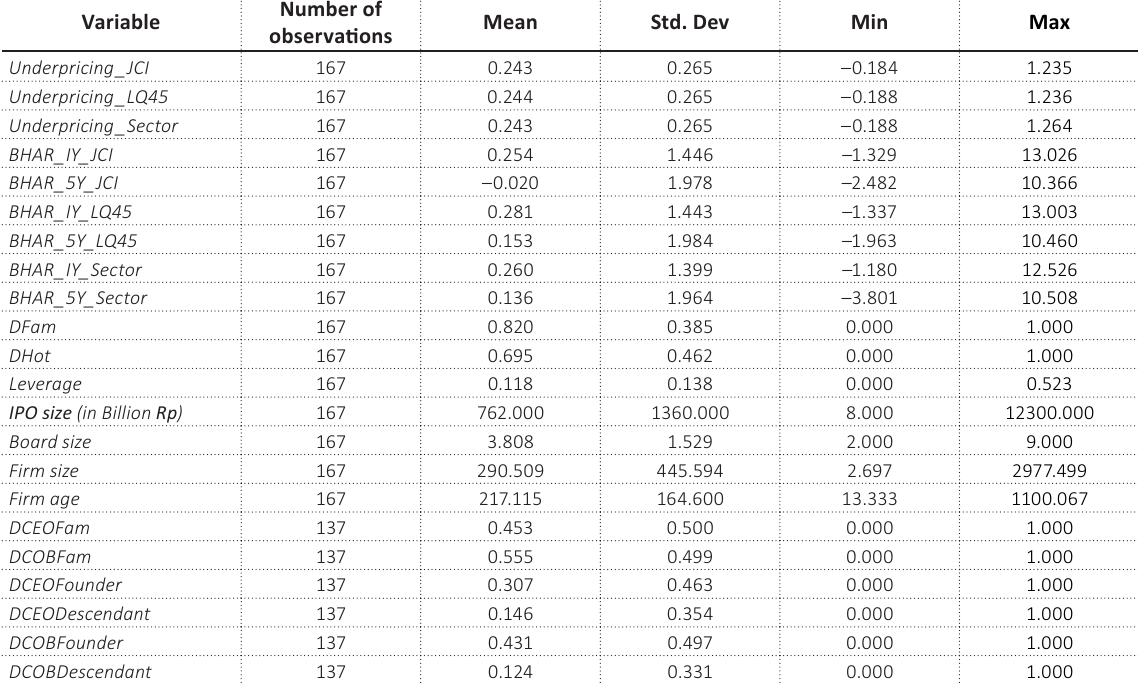
Table 3. Descriptive statistics of